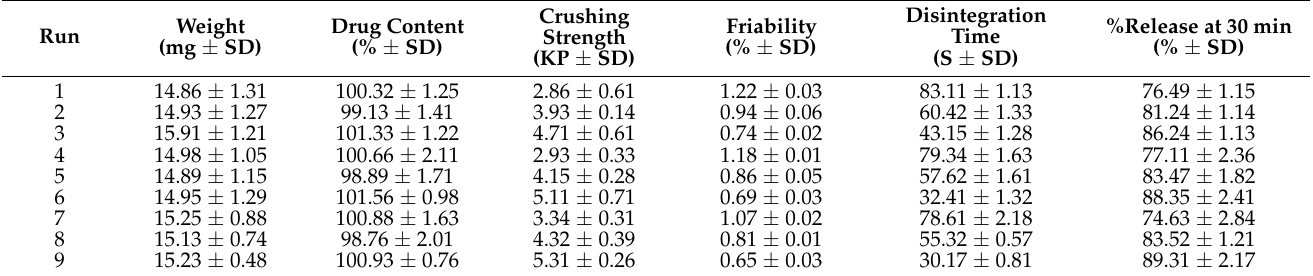
Table 7. Measured response results of prepared ODMTs (mean ±